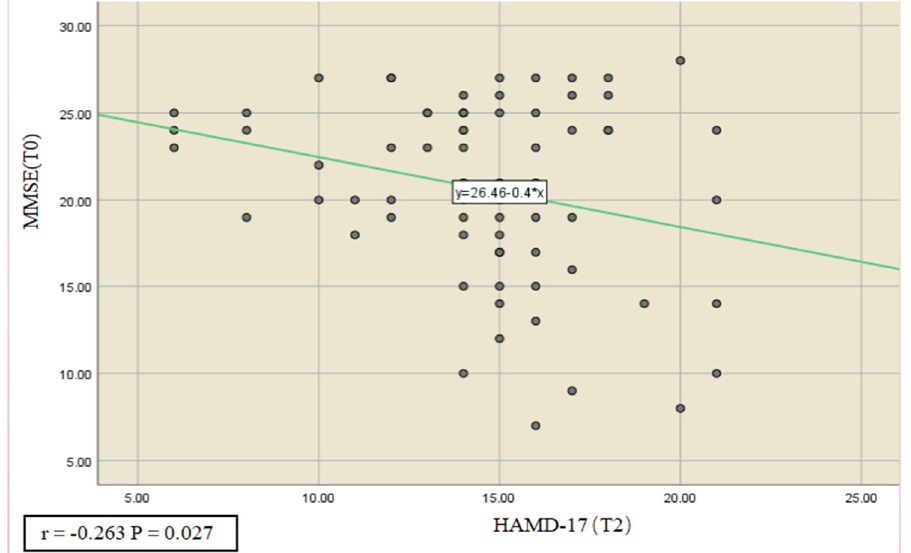
Figure 3. Pearson’s correlation analysis was performed on the cognitive roles of all subjects as a group at T 0 and HAMD−17 scores at T 2 , showing that HAMD−17 at the 8−week following up correlates negatively with MMSE (r = −0.026, p < 0.05).